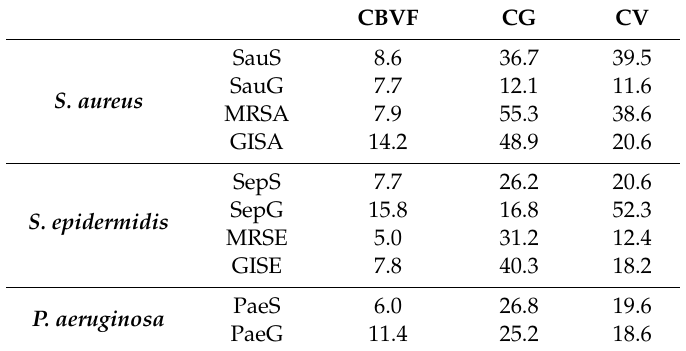
Figure 5. Ratio of live:dead cells (green:red) of ( a ) Staphylococcus aureus , ( b ) Staphylococcus epidermidis and ( c ) Pseudomonas aeruginosa isolates in biofilm formed on CBVF, CG and CV. Statistical significance: p < 0.05 (*), p < 0.01 (**) and p < 0.001 (***). Table 1. Mortality rate by CLSM analysis. Data are expressed as percentage (%) of dead cells against the